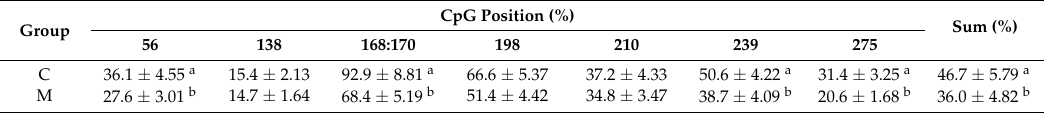
Table A4. Mean ± SEM effect of melatonin on methylation sequence of DNMT3b .